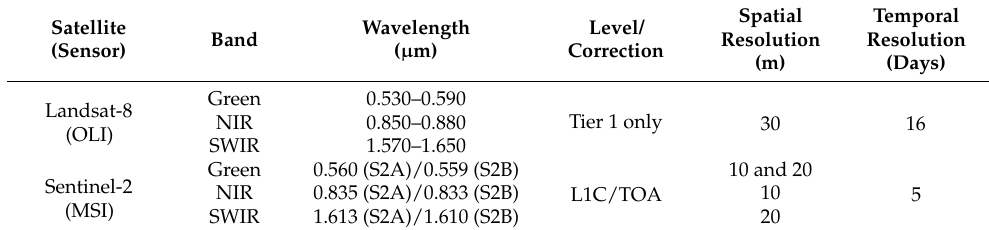
Table 2. Landsat-8 and Sentinel-2 image specifications.